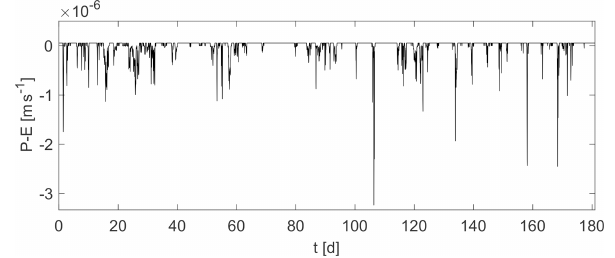
Figure 2. Net precipitation (negative) and evaporation (positive) time